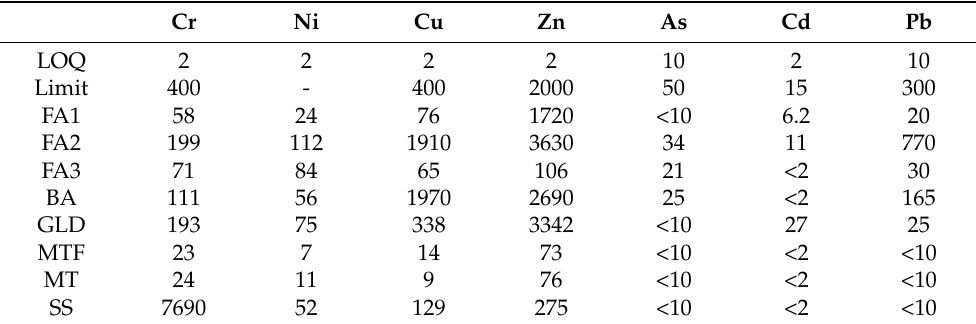
Table 7. Concentrations of hazardous elements in samples (after the complete dissolution of the solids), quantification limits (LOQ) and limit values for the content of harmful metals in fly and bottom ashes generated from coal, peat and wood according to the Finnish Government Decree 591/2006, values expressed in mg kg − 1 dry matter [45]. Cr Ni Cu Zn As Cd Pb LOQ